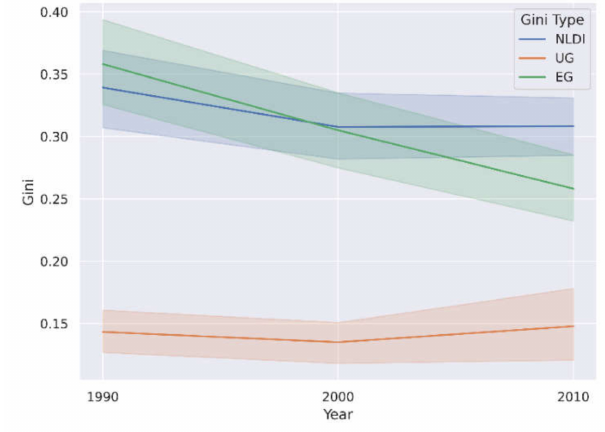
Figure 2. Growth trajectories of the Nighttime Light Development Index (NLDI), Education Gini (EG), and Urban Population Gini (UG) from 1990, 2000, and 2010 for all 141 countries with a 95% confidence